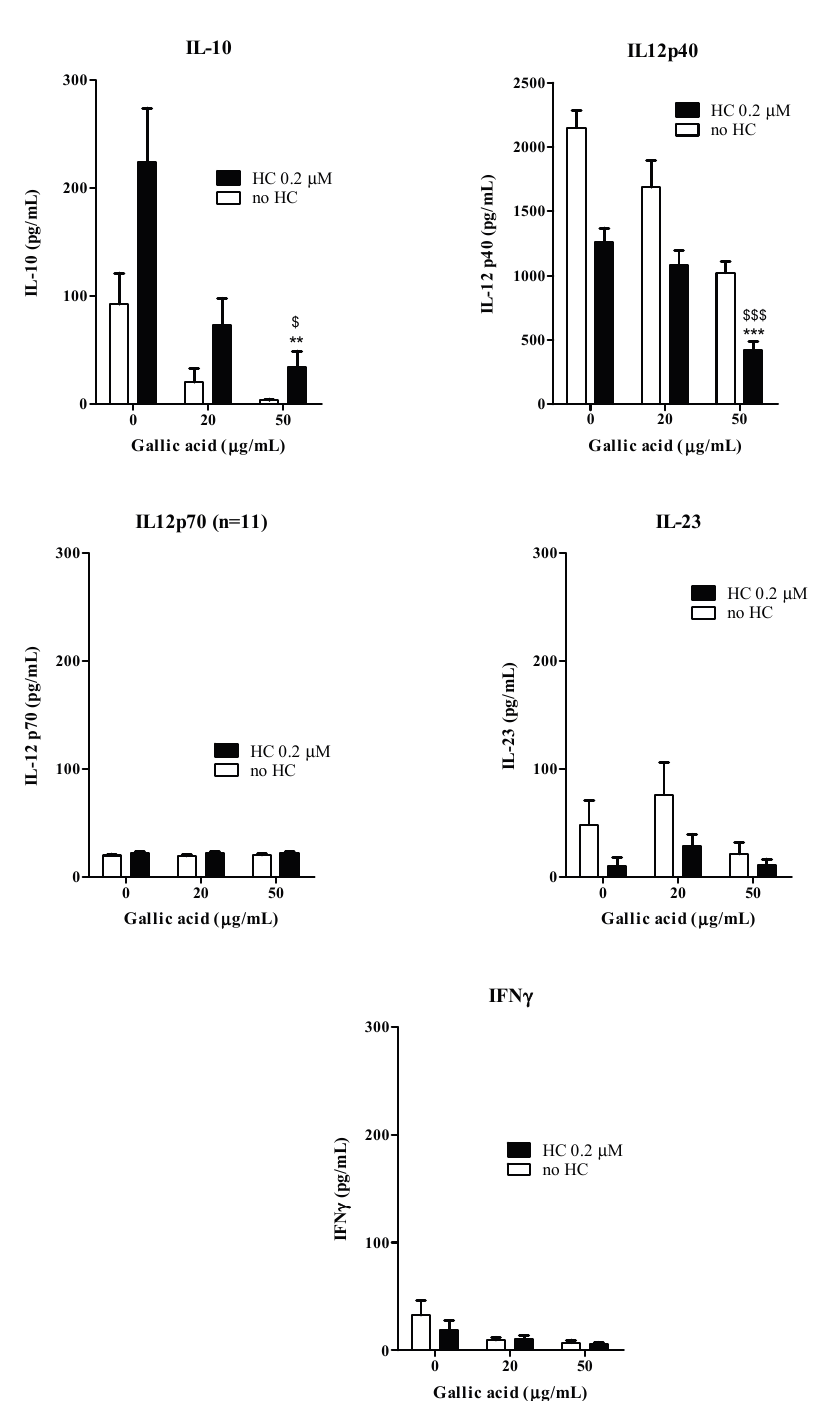
Figure 5. Combined effects of gallic acid and hydrocortisone on the cytokine production from moDC ( n = 10). The open bars represent the cells were added with gallic acid alone (0, 20 and 50 μ g/mL) and the solid bars represent the cells added with gallic acid (0, 20 and 50 μ g/mL) and hydrocortisone HC (0.2 μ M). ** and *** indicate p < 0.01 and p < 0.001, respectively, when compared the control level of the cytokine production or surface marker expression from cells without incubating with DC-inducing cytokine cocktail. $ and $$$ indicate p < 0.05 and p < 0.001, respectively, when compared the control level of the cytokine production or surface marker expression cells with HC and without incubating with DC-inducing cytokine